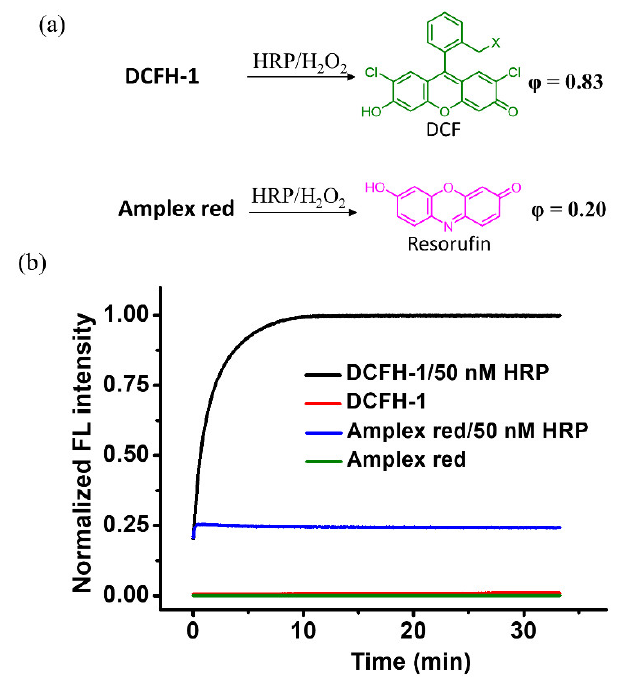
Figure 2. ( a ) The reaction and the corresponding fluorescent products generated in the substrate/HRP reaction systems. ( b ) Kinetic response curves of DCFH-1 and Amplex red upon reaction with HRP (50 nM and 0 nM), respectively, in the presence of excess amount H 2 O 2 . The maximum intensity was normalized to 1 for easier comparison.